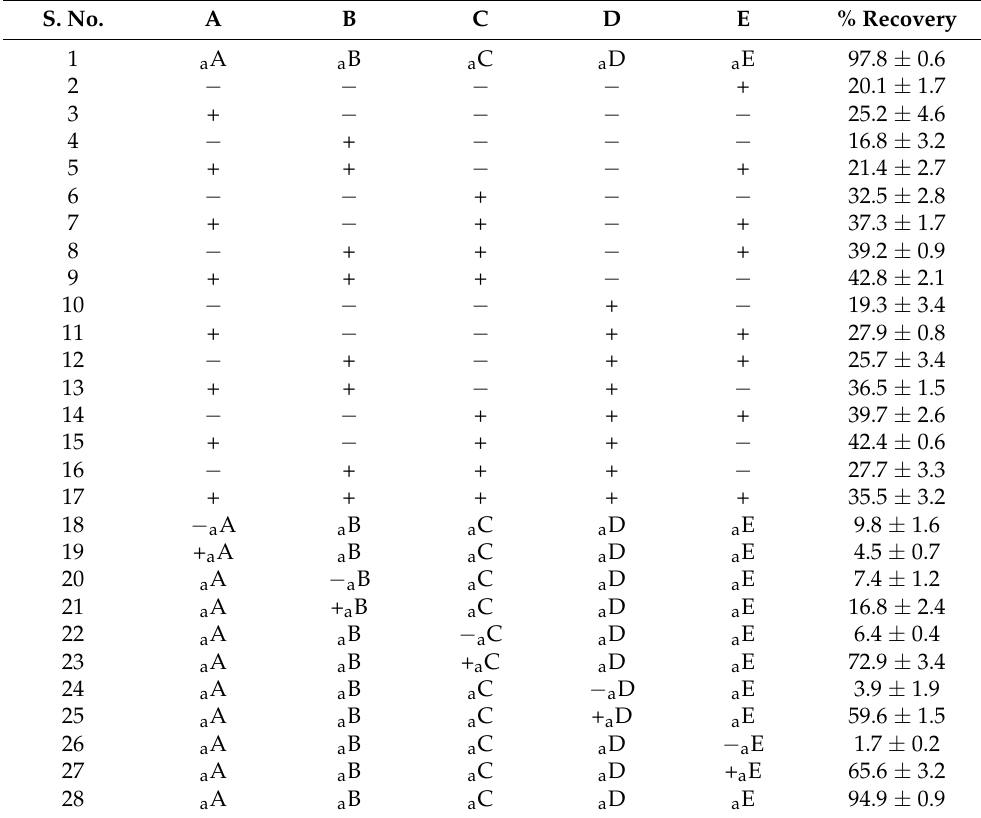
Table 2. Central orthogonal composite design for the set of